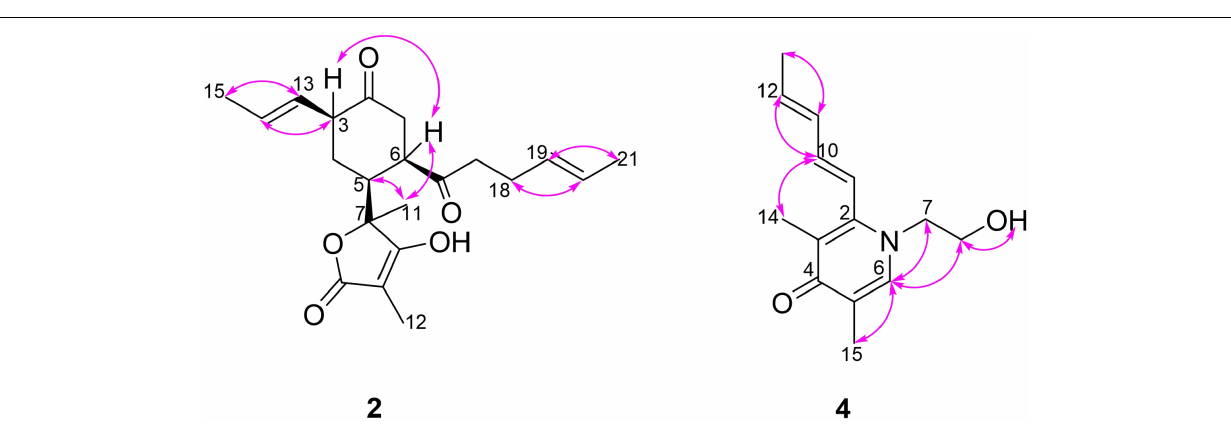
FIGURE 6 | Key NOESY and 1D NOE correlations of compounds 2 and 4